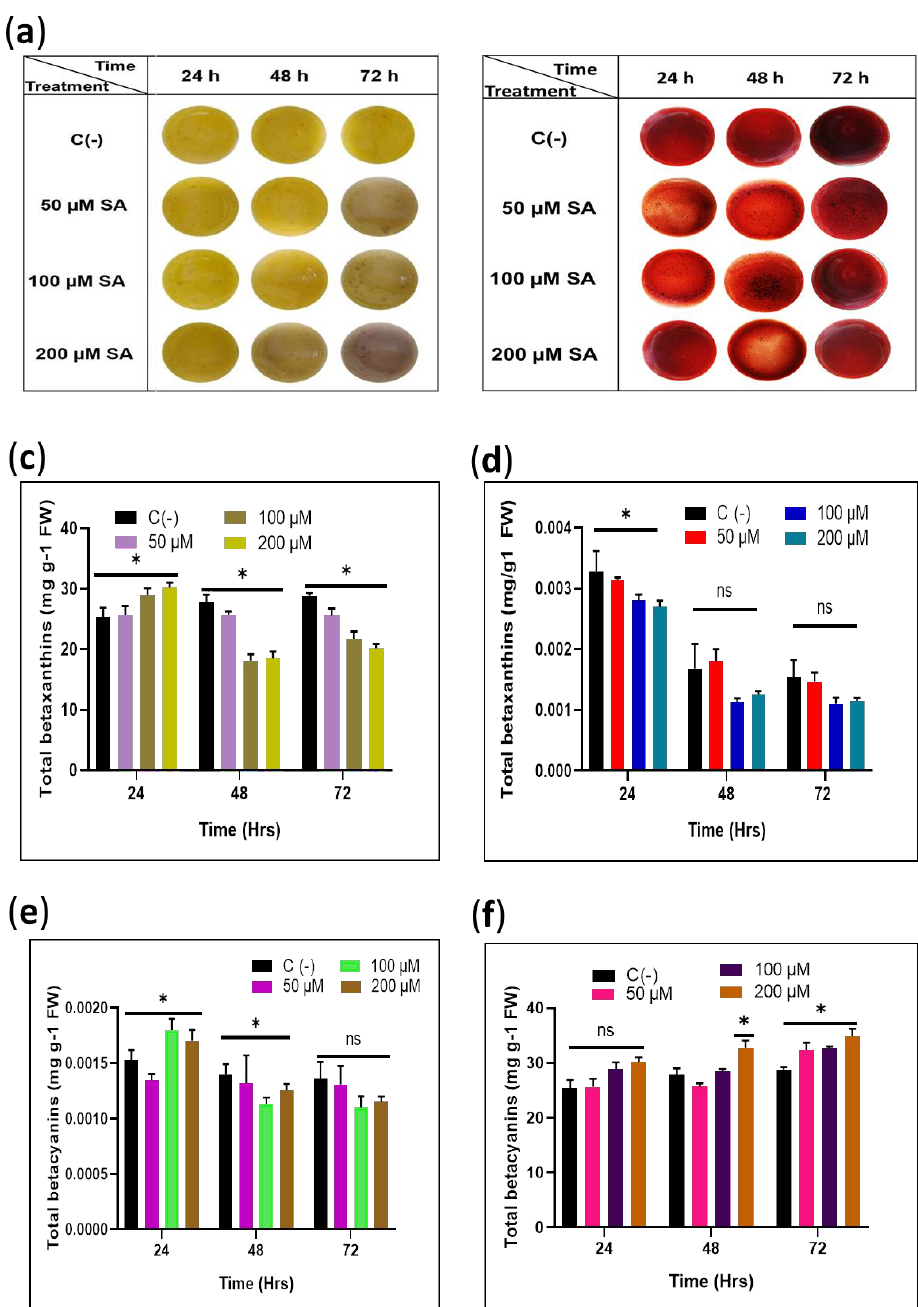
Figure 2. Evaluation of the effect of exogenous SA induction on total pigments in the sqY1 and sqR1 cells lines. ( a ) Culture cells after sedimentation from sqY1 cultivation under different time and treatment of SA. ( b ) Culture cells after sedimentation from sqR1 cultivation under different time and treatment of SA. ( c , e ) Quantification of betaxanthins and betacyanins for all treatments of sqY1. ( d , f ) Quantification of betaxanthins and betacyanins as stated in materials and methods for all treatments of sqR1. All experiments were obtained at a significance level of α = 0.05 with three independent replicates. Bar indicates standard error. (*) Indicate statistical significance at p < 0.05. (ns) Indicate no statistical